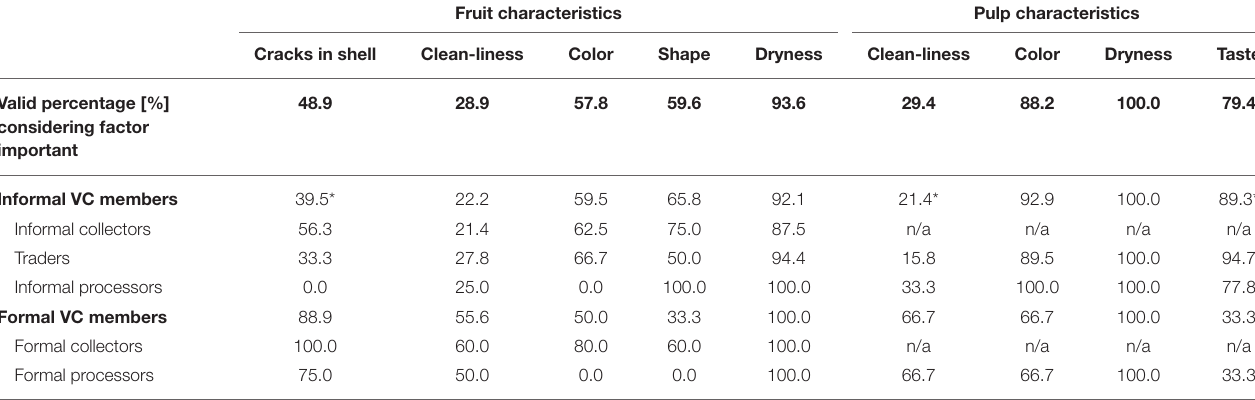
TABLE 2 | Importance of different quality indicators for baobab fruit and pulp as judged by various value chain members handling these products ( n = 56).